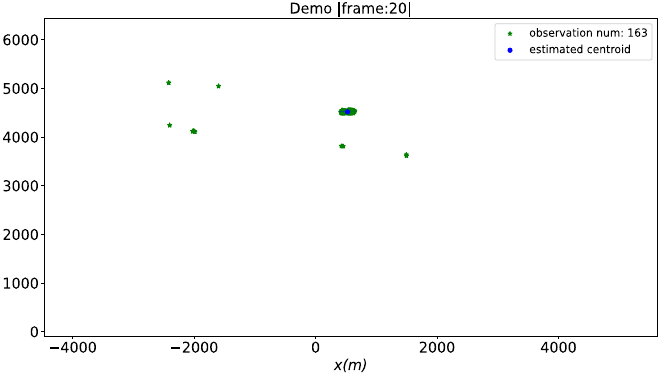
Figure 8. Single target in the Cartesian coordinate system tracking in the 20th frame.